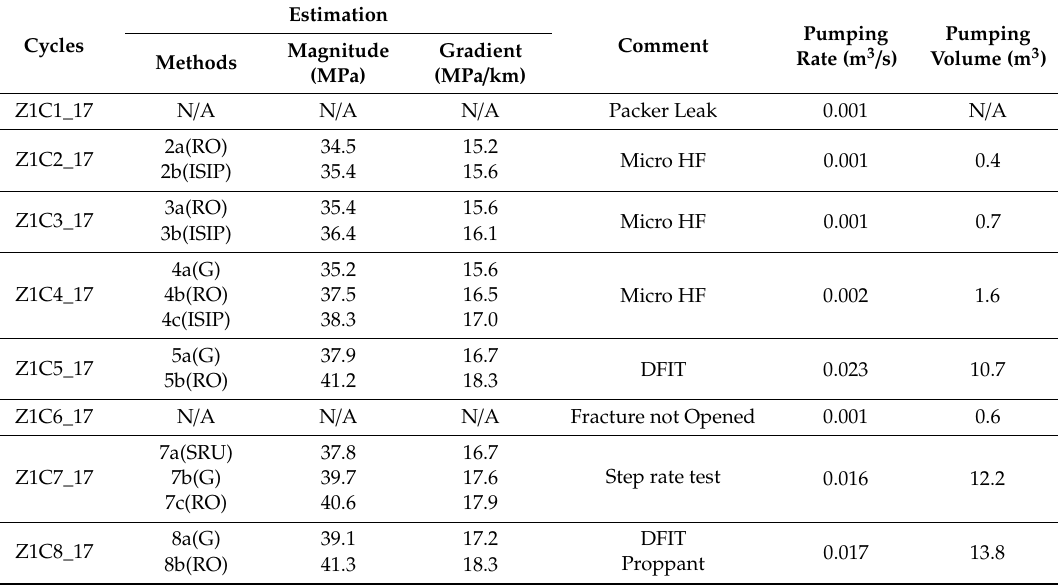
Table A1. Summary of the stress measurement results of Zone 1, 2017 (true vertical depth (TVD) is 2262 m).